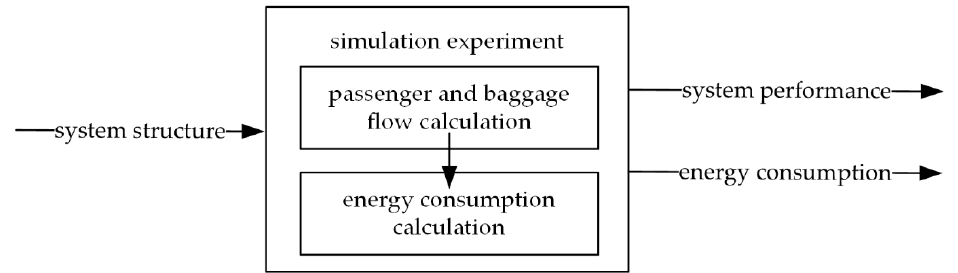
Figure 1. Simulation model structure.